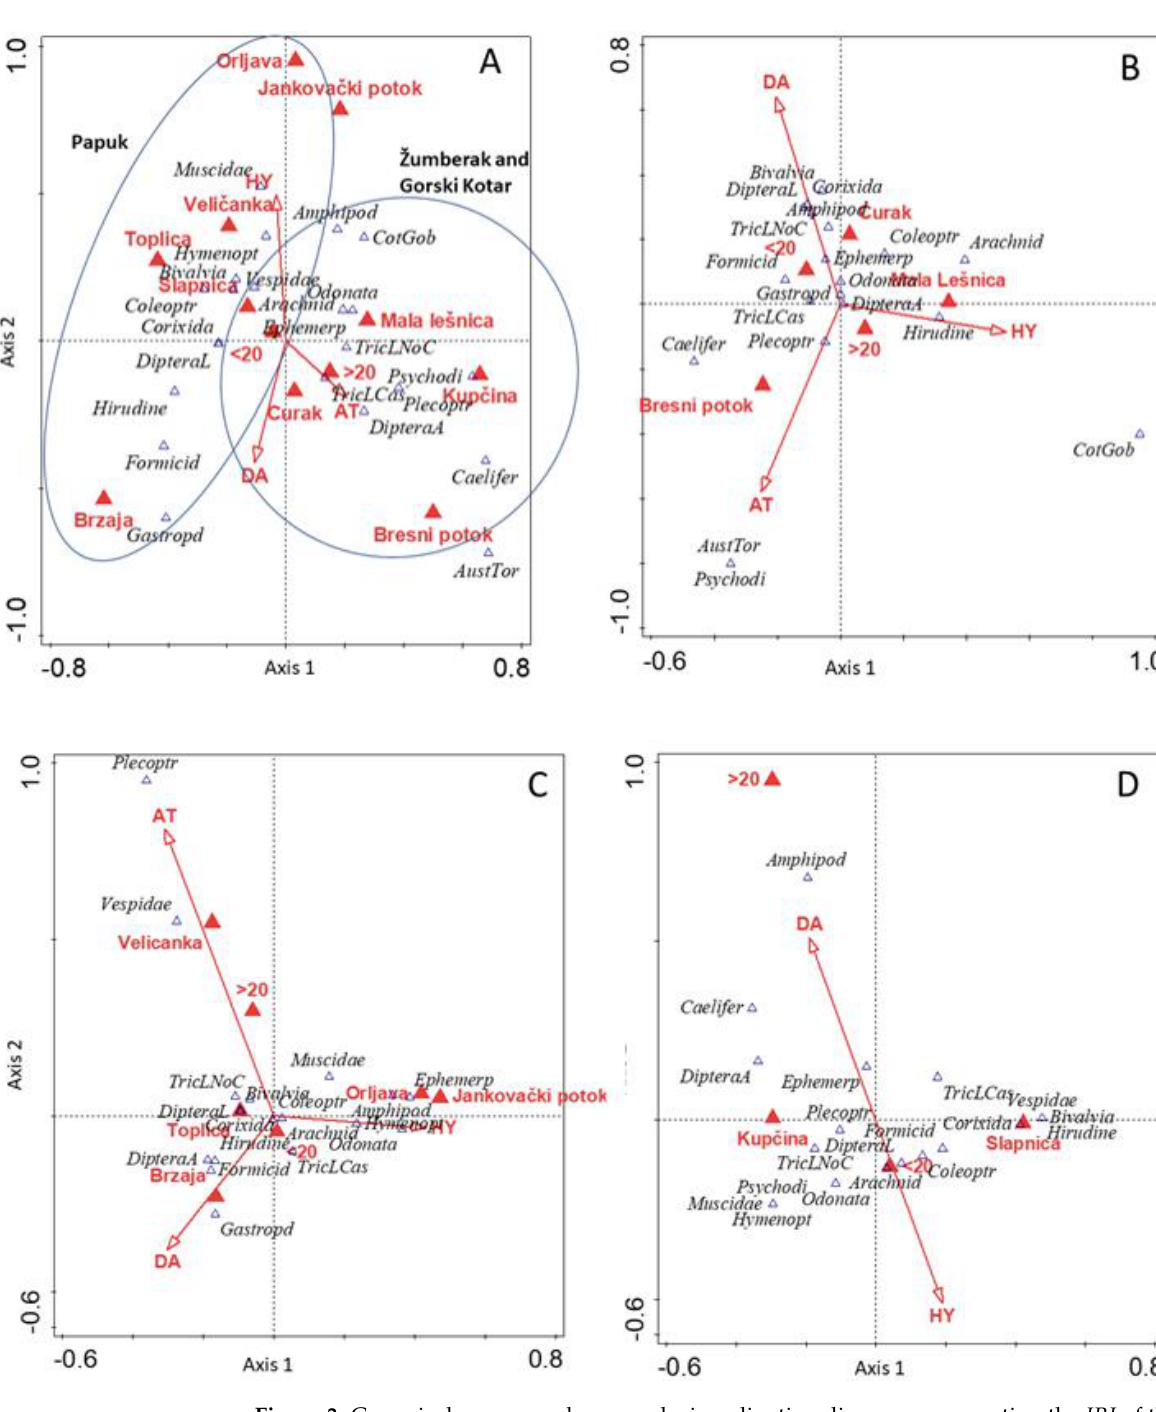
Figure 3. Canonical correspondence analysis ordination diagram representing the IRI of the main prey items of brown trout at each sampling site. ( A ) Total variation is 6.79, and explanatory variables account for 25.0% of the variation; Monte Carlo permutation test results on all axes: pseudo-F = 2.0, p = 0.002. ( B ) Gorski Kotar: total variation is 6.06, and explanatory variables account for 32.3% of the variation; Monte Carlo permutation test results on all axes: pseudo-F = 1.4, p = 0.024. ( C ) Papuk: total variation is 4.50, and explanatory variables account for 36.1% of the variation; Monte Carlo permutation test results on all axes: pseudo-F = 1.9, p = 0.002. ( D ) Žumberak : total variation is 5.09, and explanatory variables account for 25.0% of the variation; Monte Carlo permutation test results on all axes: pseudo-F = 1.2, p = 0.198; ( → — dummy explanatory variables ▲ — nominal explanatory variables,